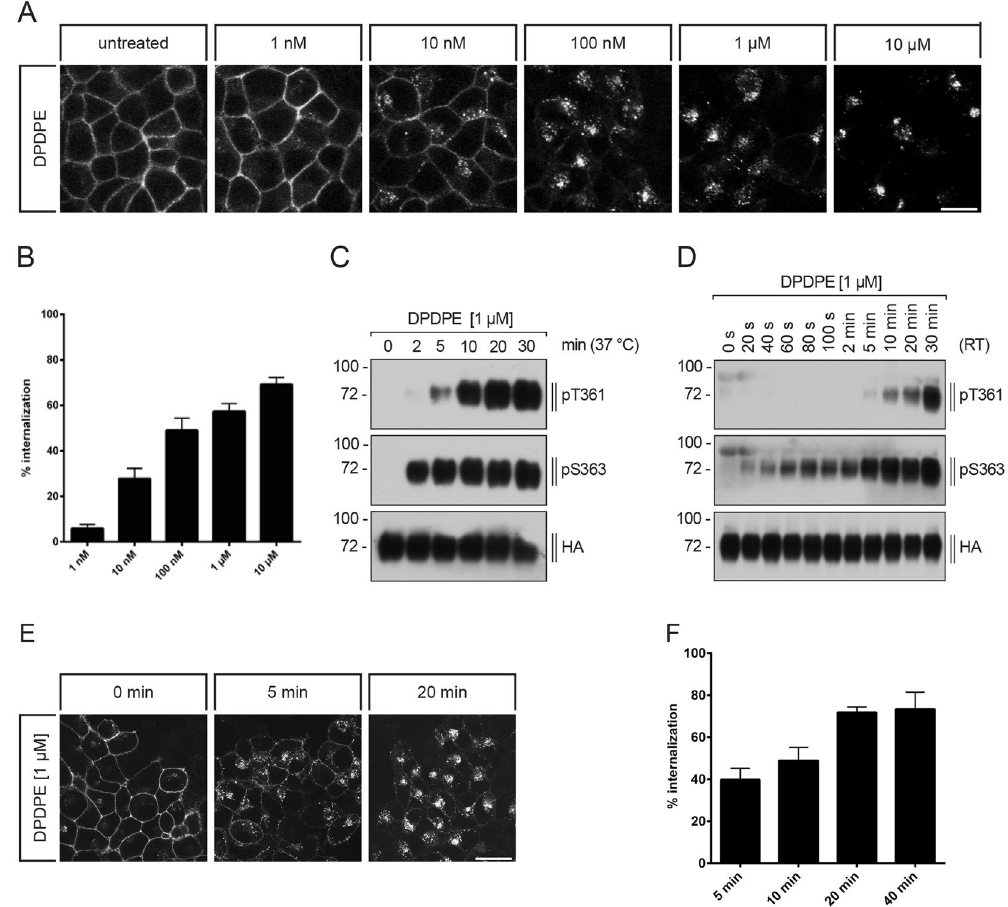
Figure 2. Time course of DPDPE-induced DOP receptor phosphorylation, concentration-dependent DOP receptor phosphorylation and internalization. ( A ) HEK293 cells stably expressing HA-tagged hDOP receptor were preincubated with anti-HA antibody and stimulated with the indicated DPDPE concentrations for 30 min at 37 °C. After stimulation, cells were fixed, permeabilized, immunofluorescently stained and examined using confocal microscopy. Images are representative from one of three independent experiments. Scale bar, 20 µ m. (B) Cells described in (A) were preincubated with anti-HA antibody and stimulated with the indicated DPDPE concentrations for 30 min at 37 °C. After fixation, cells were labeled with a peroxidase-conjugated secondary antibody and receptor internalization was measured by enzyme-linked immunosorbent assay. Receptor internalization was measured by ELISA and quantified as the percentage of internalized receptors compared to untreated cells. Data are means ± SEM of four independent experiments performed in quadruplicate. (C,D) Cells described in ( A ) were exposed to 1 µ M DPDPE for the indicated times and temperatures ( C ) at 37 °C, ( D ) at 22 °C (room temperature, RT) and lysates were immunoblotted with anti-pT361 or anti-pS363 antibodies. Blots are representative of n = 4 ( C ) or n = 5 ( D ) independent experiments. (E) Cells described in (A) were preincubated with anti-HA antibody and thereafter stimulated with 1 µ M DPDPE for the indicated durations at 37 °C. Cells were fixed, permeabilized, immunofluorescently stained and examined using confocal microscopy. Images are representative from one of three independent experiments. Scale bar, 20 µ m. (F) Cells described in ( A ) were preincubated with anti-HA antibody and stimulated with 10 µ M DPDPE for the indicated durations at 37 °C. Cells were fixed and labeled with peroxidase-conjugated secondary antibody. Receptor internalization was measured by ELISA and quantified as the percentage of internalized receptors in agonist- treated cells compared to untreated cells. Data are mean ± SEM of five independent experiments performed in